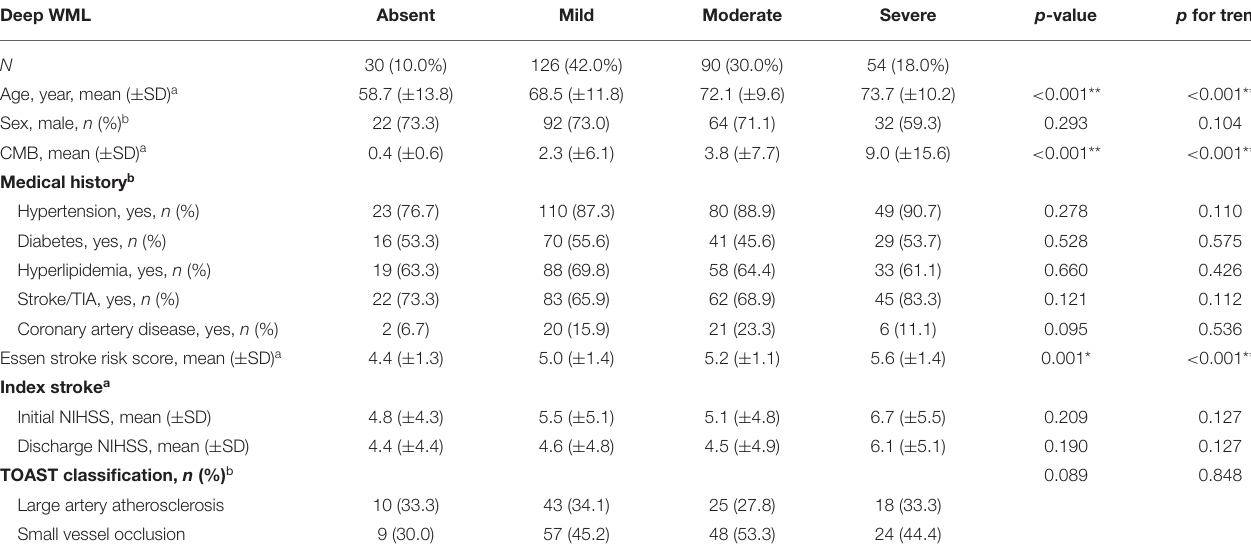
TABLE 3 | Relationship between deep white matter lesions and characteristics of stroke patients with aspirin treatment failure. Deep